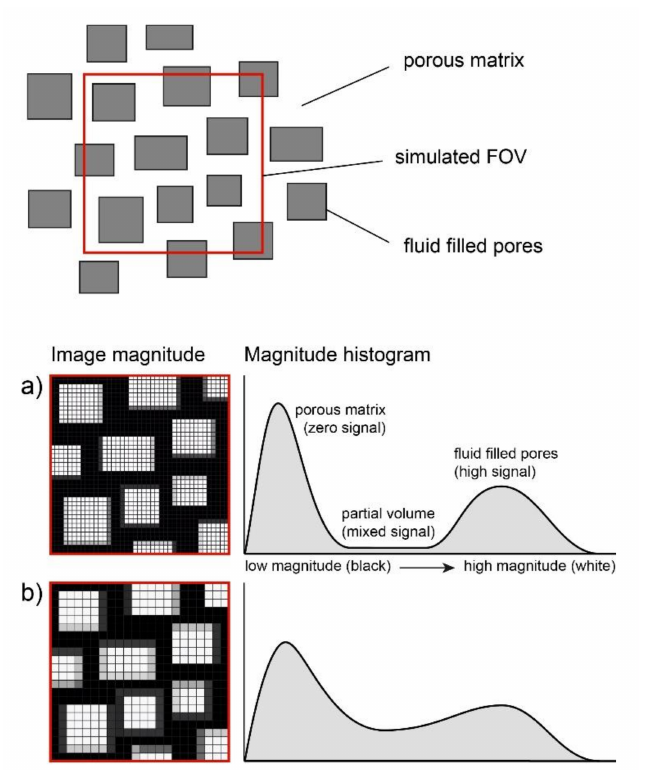
Figure 1. The effect of the voxel size on the distribution of the image magnitude illustrated with a simulated measurement of a porous sample with ( a ) high resolution and ( b ) low resolution. ”FOV” stands for “field of